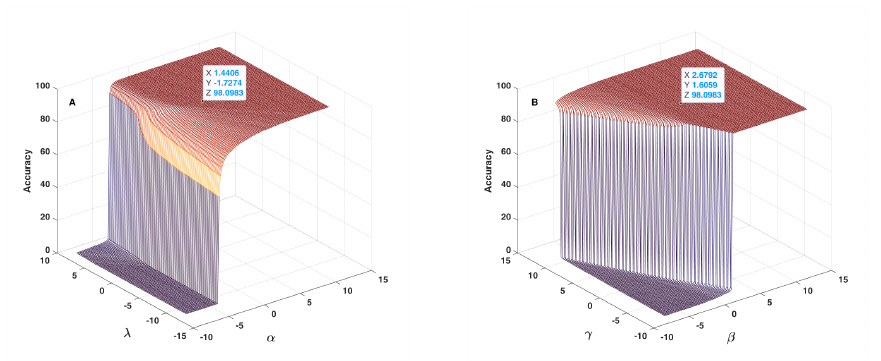
Figure 12. Accuracy in terms of α and β parameters ( A ) and of α and γ parameters ( B ) used in the fusion step (Equation (14)).